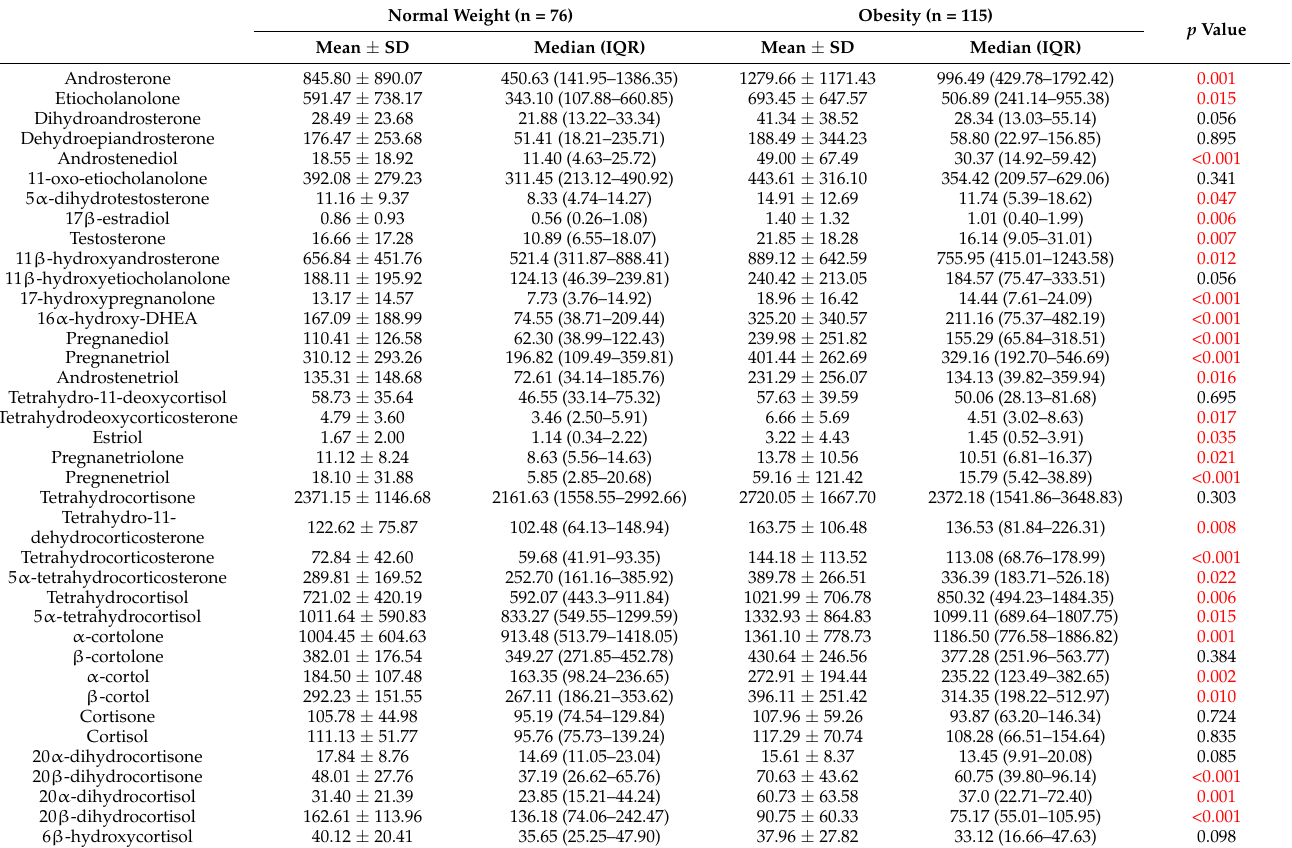
Table 2. List of steroid metabolites ( µ g/24 h): differences between the normal weight and obesity groups.